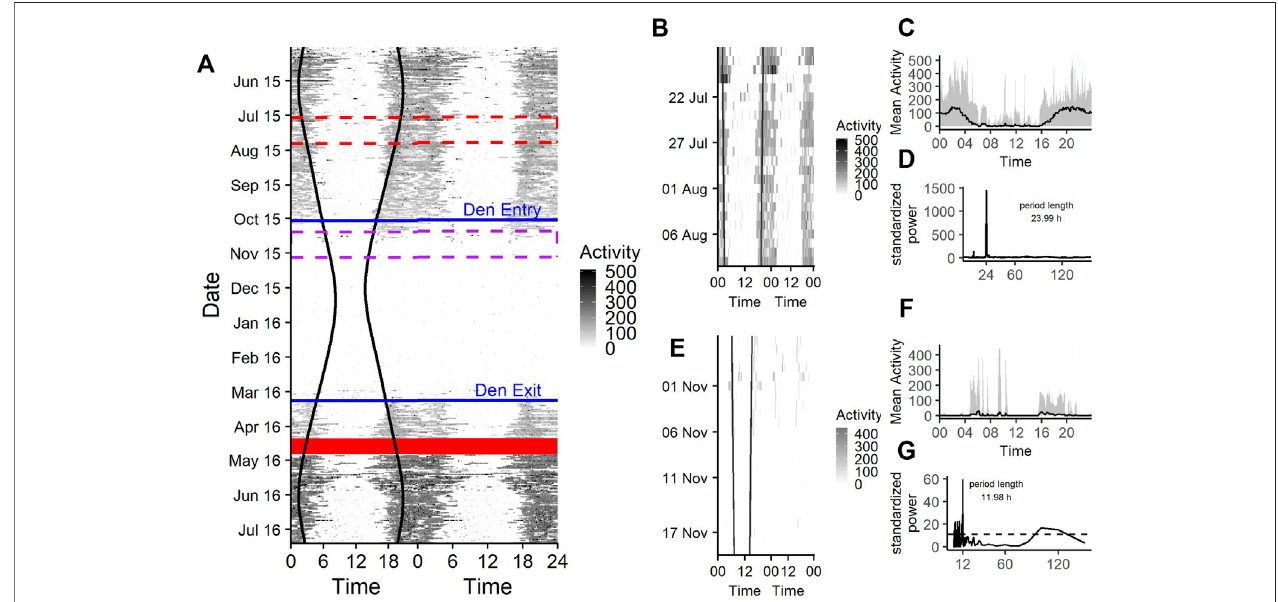
FIGURE 2 | (A) Doupleplot actogram of the raw activity data of a 7 year old male Brown bear ( Ursus arctos ) with measurements from 15th May 2015 – 31st July 2016.The x axisrepresentsthetimeofdayx(left)andx+1 day(right)frommidnighttomidnightandthe y axisrepresentsthetimeoftheyearindays.Activityisvisualized withacolorgradientfromwhitetoblackwithincreasingactivityvalues.Sunriseandsunsettimearerepresentedasblackverticallines,theexcluded14 daysaftercapture (29th April 2016) are shown as a red ribbon and the den entry and den exit days are indicated as blue horizontal lines. The red and purple dashed rectangle are zoomillustrationsfora25-daystimespanduringtheactivestate (B) andhibernation (E) .Themeanactivityduringthe25-daystimespansoveradayareshownin (C) and (F) and the corresponding Lomb-Scargle Periodograms and the period lengths for this time span are shown in (D) and (G)